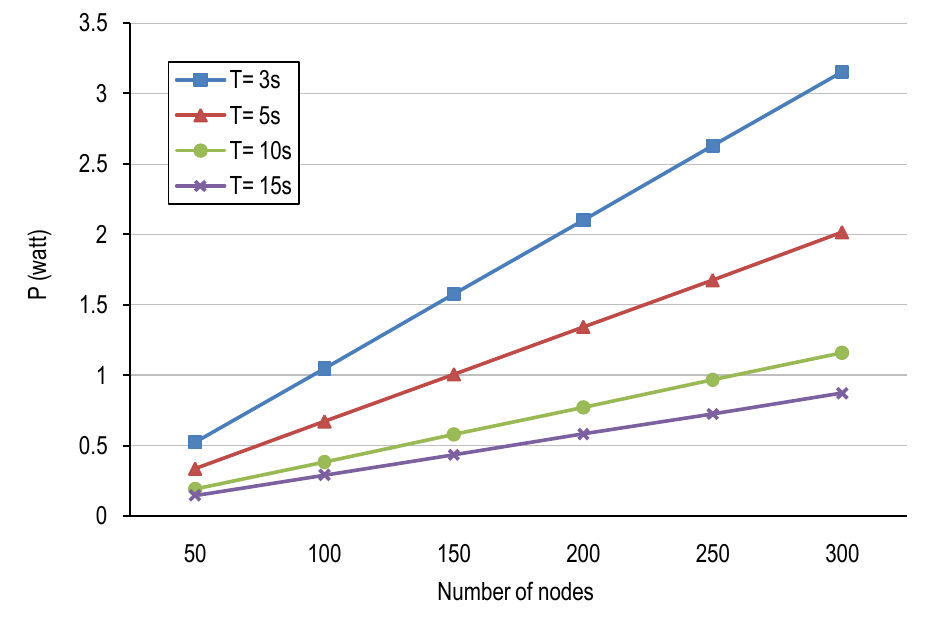
Figure 13. Consumed power (P) for a non-cooperative tier/network of nodes consisting of